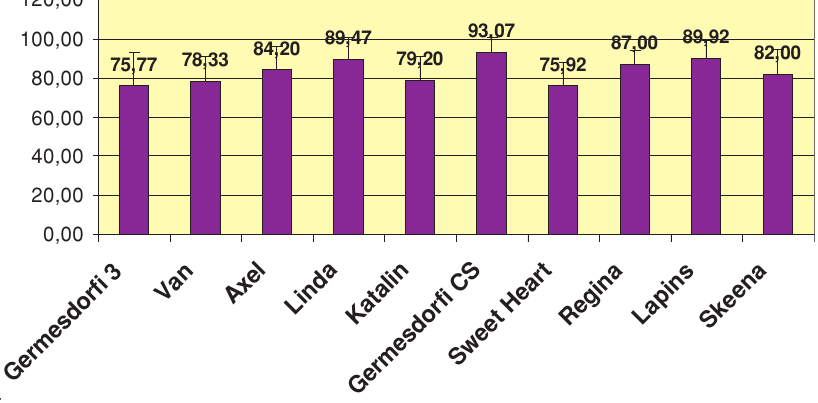
Figure 10. Evaluation of late ripening sweet cherry varieties according to the general